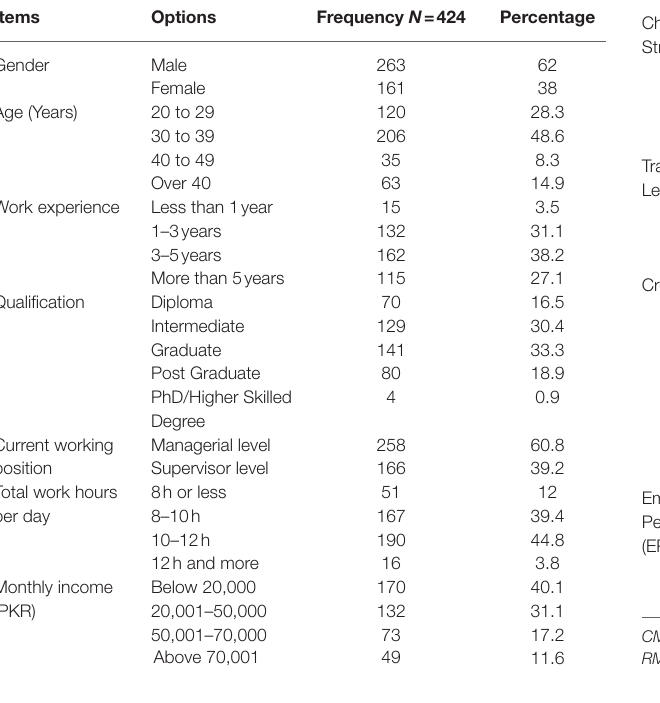
TABLE 1 | Demographic